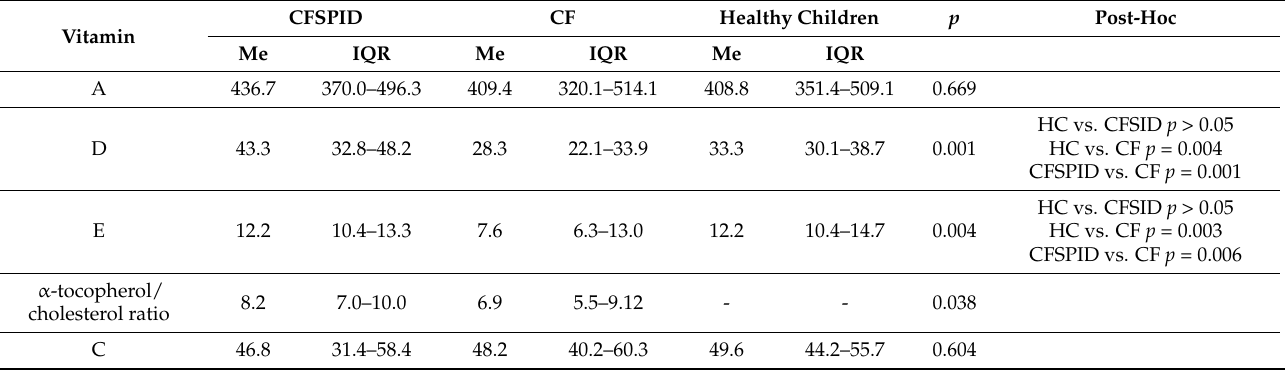
Table 3. Distribution of vitamin A, D, E, and C blood concentration values among different groups.